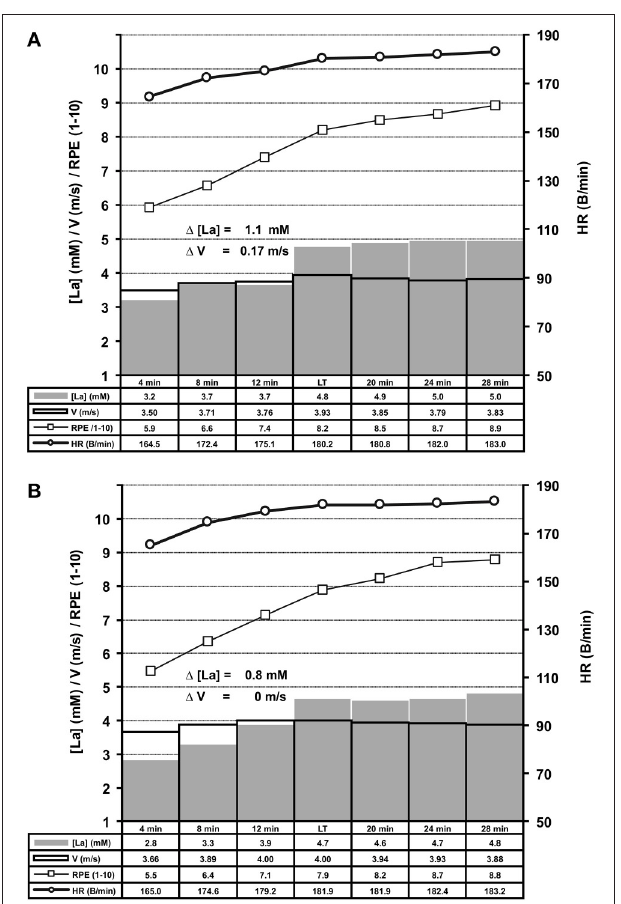
FIGURE 5 | Summary of treadmill ILT-Tests which met threshold criterion 1 ( A , n = 169) or 2 ( B , n = 109). Group mean values are shown for arterial lactate concentration (mM) [La], velocity (m/s), heart rate (B/min) and RPE (1–10). Note the steep [La] increase at the lactate threshold (LT) in response to a slight increase of treadmill velocity. (A) Threshold criterion 1, 1 [La] = 1.1 ± 0.44mM, 1 V = 0.17 ± 0.06 m/s; ( B) Threshold criterion 2, 1 [La] = 0.8